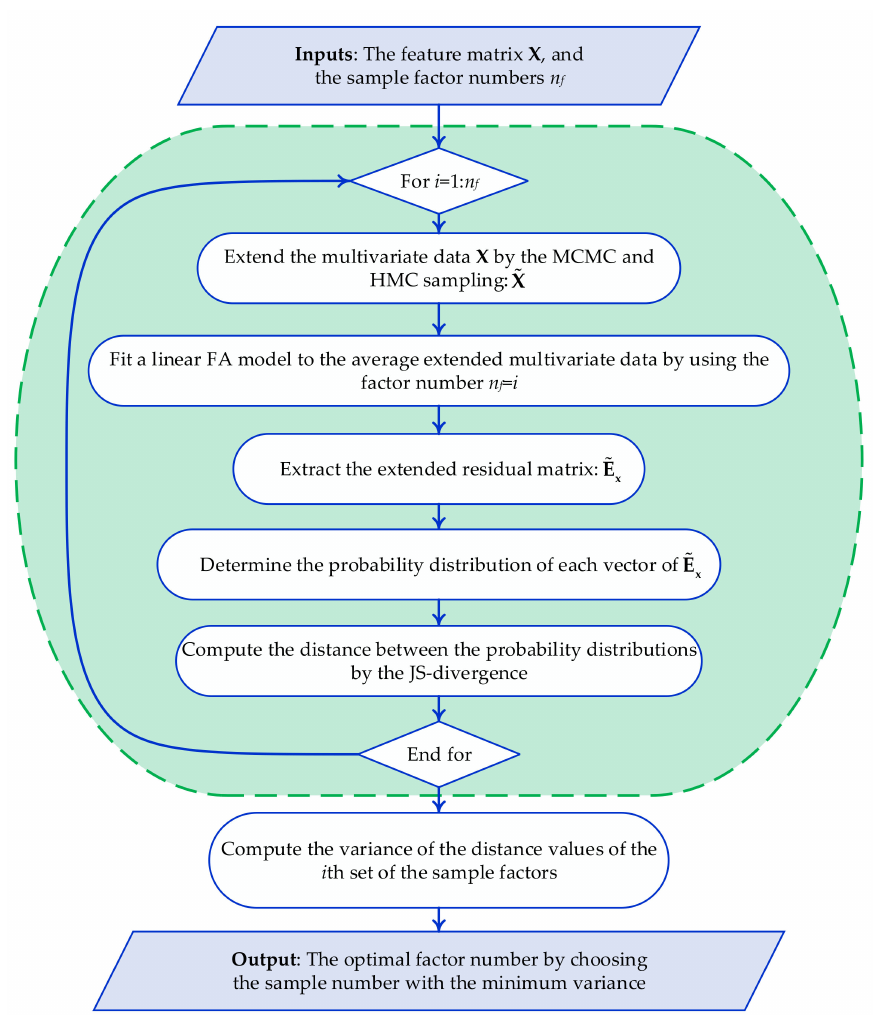
Figure 2. Flowchart of the proposed approach to set the optimal number of